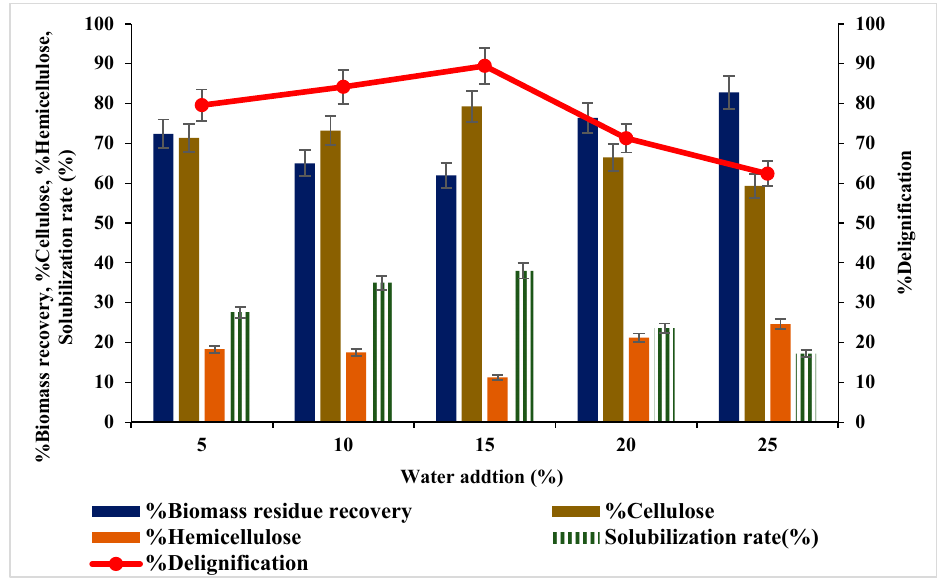
Figure 3. E ff ect of diluted ChCl: LA DES on deligni fi cation of Atriplex crassifolia . Figure 3. Effect of diluted ChCl: LA DES on delignification of Atriplex crassifolia